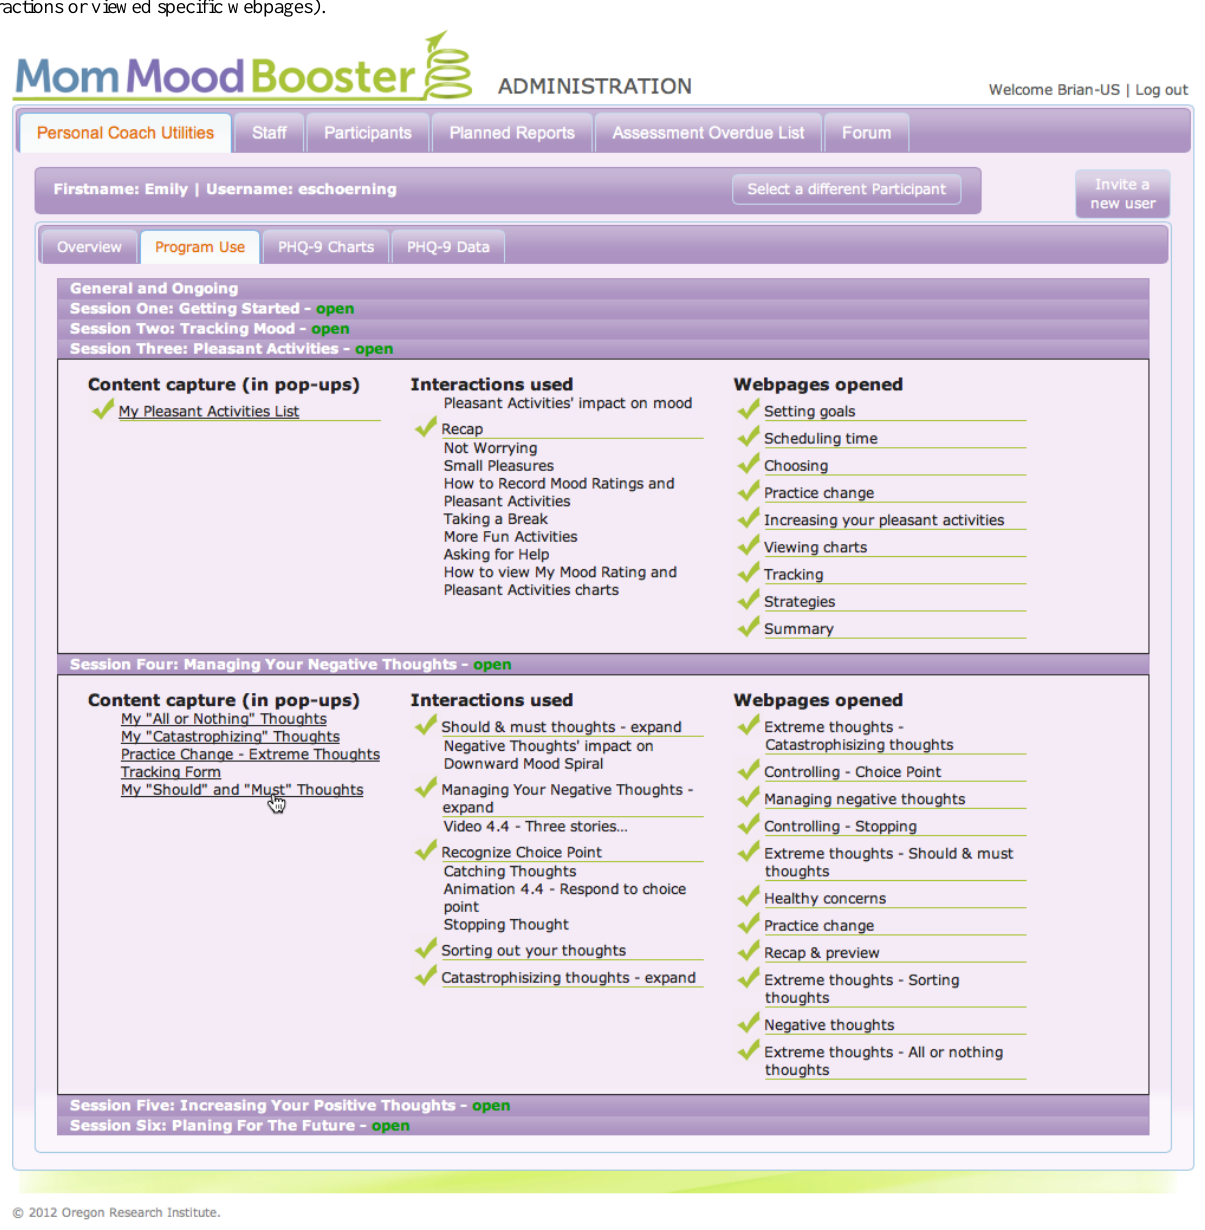
Figure 3. Dashboard for Personal Coach Webpage in MomMoodBooster Administrative Website (checkmarks indicate that participant has used certain interactions or viewed specific